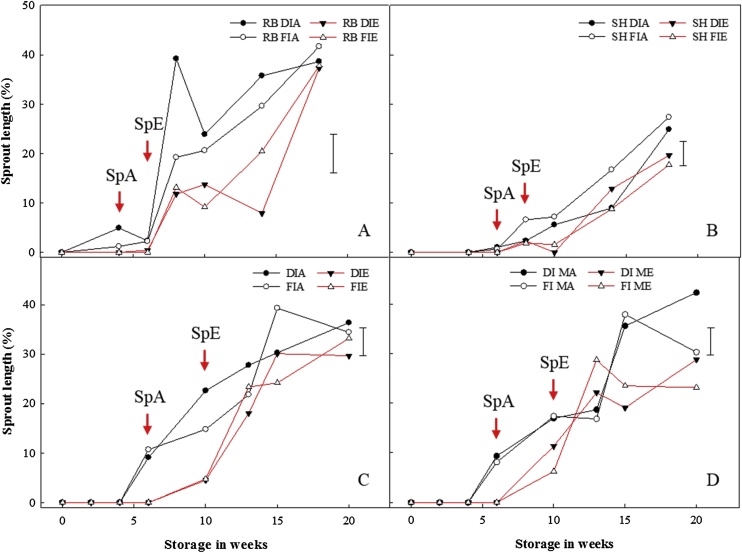
Sprout length in stored onion bulbs. Sprout length was measured as sprout length in proportion to bulb height represented as a percentage for onion bulbs of cultivar ‘Red Baron’ (RB) and ‘Sherpa’ (SH) grown in 2015 (A and B) and 2016 (C and D) under full irrigation (FI) or deficit irrigation (DI); where FI amounted to 100% replenishment of crop evapotranspiration (ETc) and DI was ETc replenishment at 50%. Bulbs were harvested at full maturity (100% fall-down) and cured under glass for six weeks for both years. After curing, bulbs were either treated with 1-MCP at 1 μL L−1 for 24 h or untreated before storage; and then, stored at 1 °C under continuous ethylene supplementation at 10 μL L-1 or air. DIA and FIA are DI and FI bulbs in air, DIE and FIE are DI and FI bulbs stored under ethylene, DIMA and FIMA are DI and FI bulbs treated with 1-MCP and stored in air and DIME and FIME are DI and FI bulbs treated with 1-MCP and stored under ethylene. SpA and SpE are sprout emergences for bulbs stored in air and ethylene, respectively. LSD bar at 95% confidence shown.